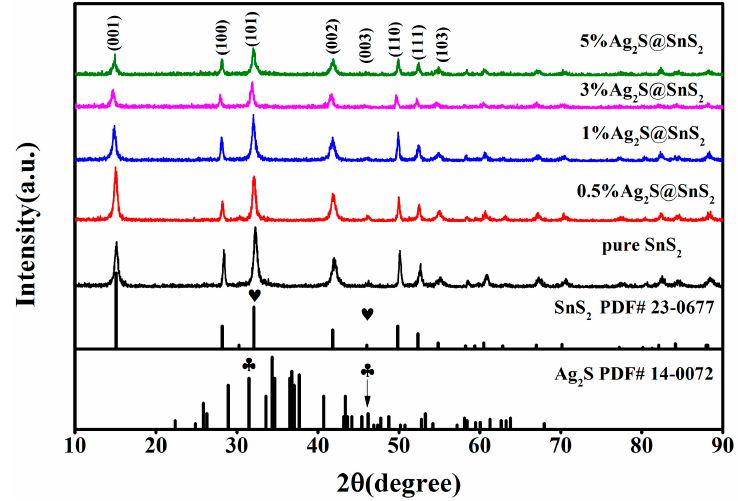
Figure 1. X-ray diffraction pattern of pure SnS 2 and Ag 2 S@SnS 2 composites.